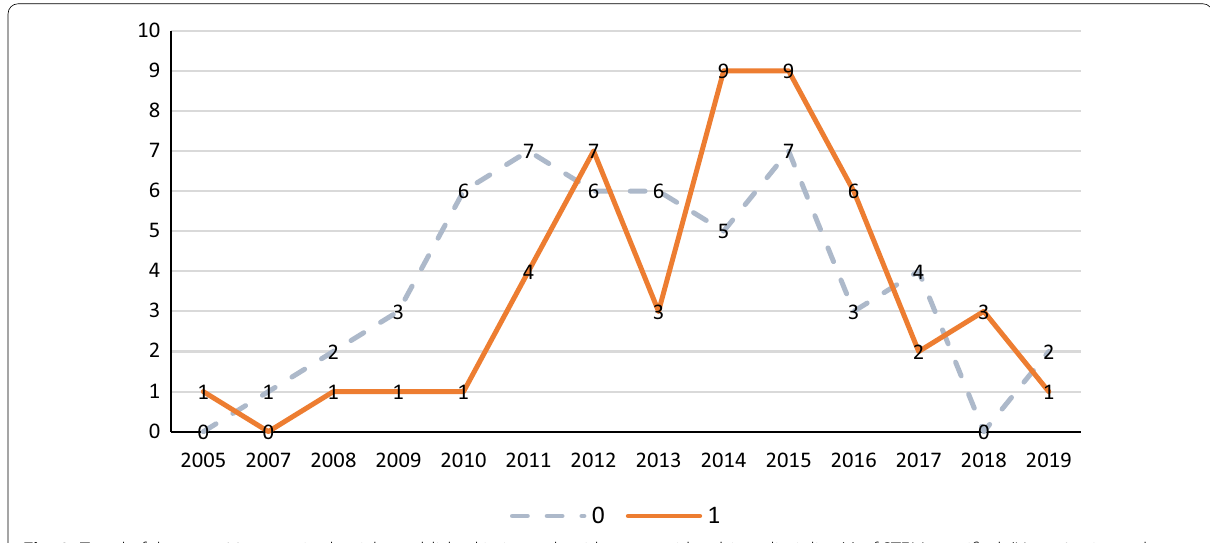
Fig. 3 Trend of the top 100 most-cited articles published in journals without vs. with subject discipline(s) of STEM specified. (Note: 0 without STEM discipline specified, 1 journals with STEM discipline(s) =